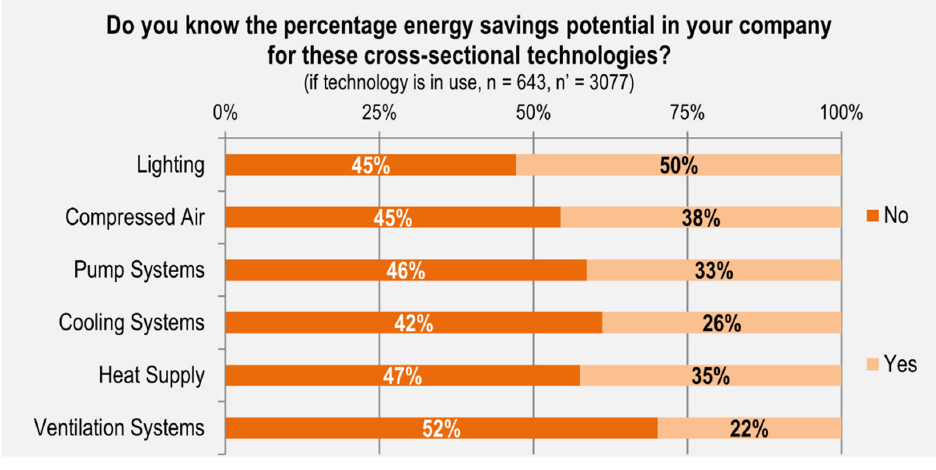
Figure 9. Companies’ knowledge of their percentage energy savings potential in cross-cutting technologies they use [42].